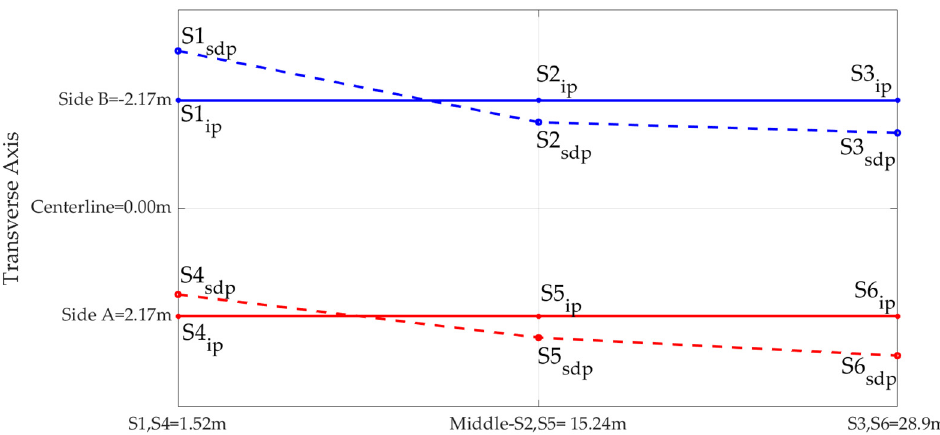
Figure 20. 4th Identified mode shape-2nd lateral with sensor 4 as reference at 7.81 Hz.